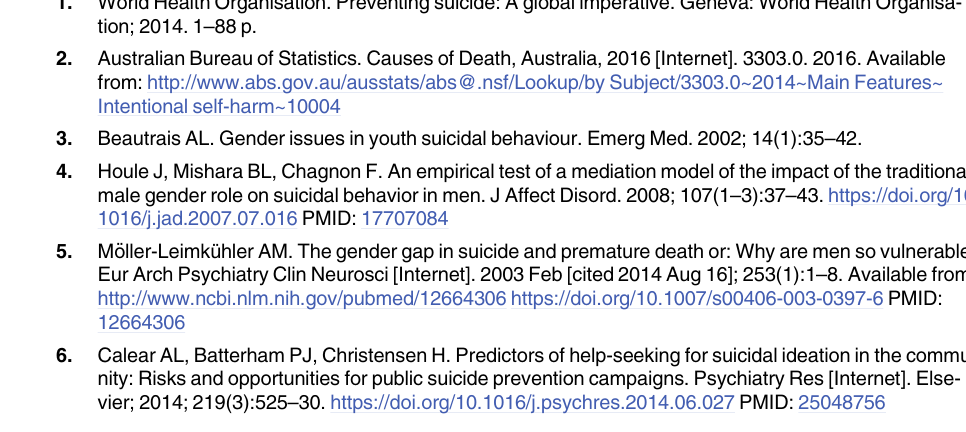
S1 Table. Summary of findings and suicide sign label. S2 Table. Suicide sign label and description. S3 Table. PRISMA